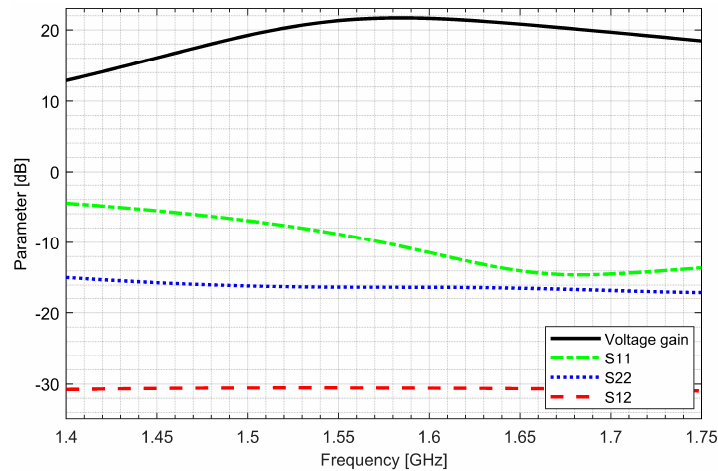
Figure 4. S-matrix and voltage gain characteristics of the L1/E1 low-noise amplifier.